Question: Condense the content of this figure into a single sentence.
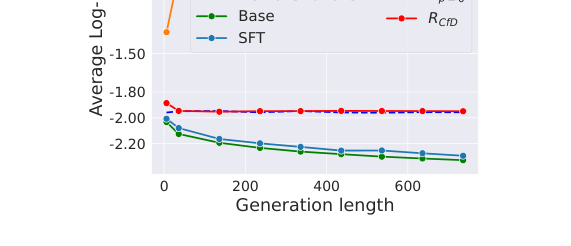
Answer: Average log-likelihood as a function of the generation length. Optimizing Rβ=0 finds LLM ex- ploits to minimize the likelihood, while imitation-based models suffer from exposure bias. Only RCfD has an average log-likelihood that matches human behavior.